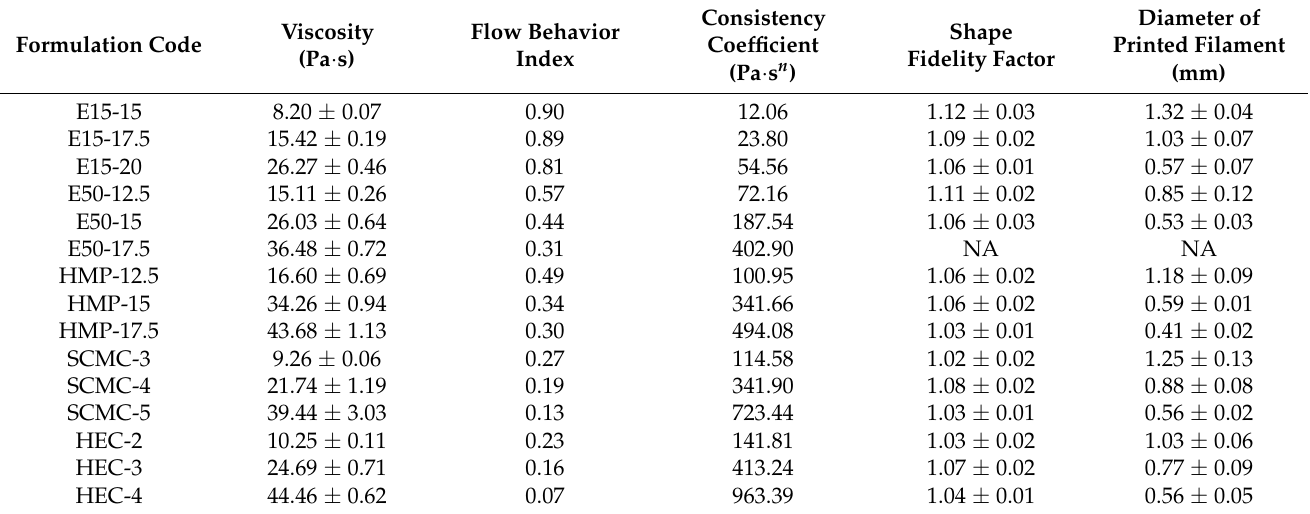
Table 2. Rheological and printability parameters of different concentrations of HPMC E15, HPMC E50, HMP, SCMC, and HEC formulations.